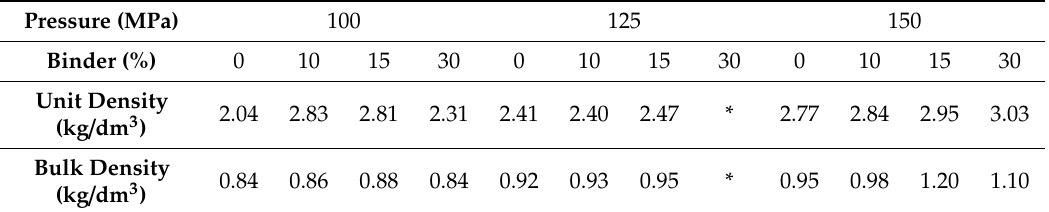
Table 2. Unit and bulk density of biomass briquettes produced at di ff erent pressure and di ff erent binder